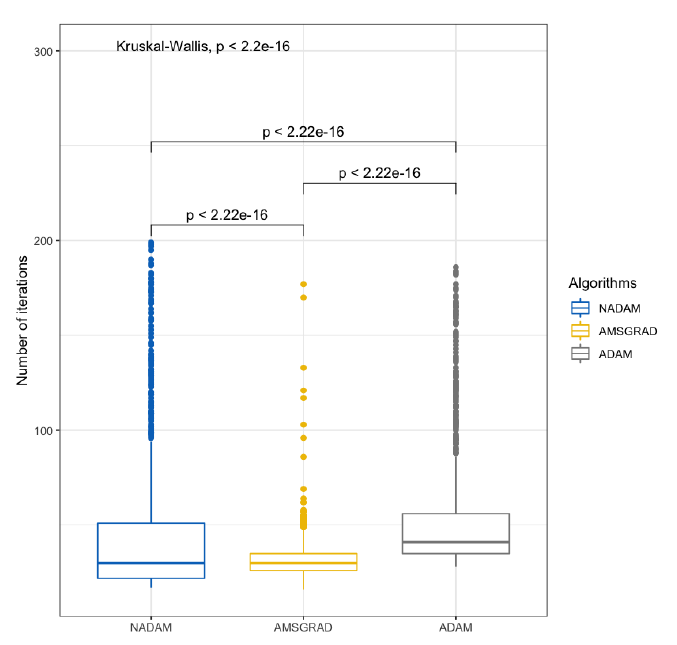
Figure 4. Kruskal–Wallis paired test for the number of iterations between different groups of optimizers with the resulting p -value of the test for each group.